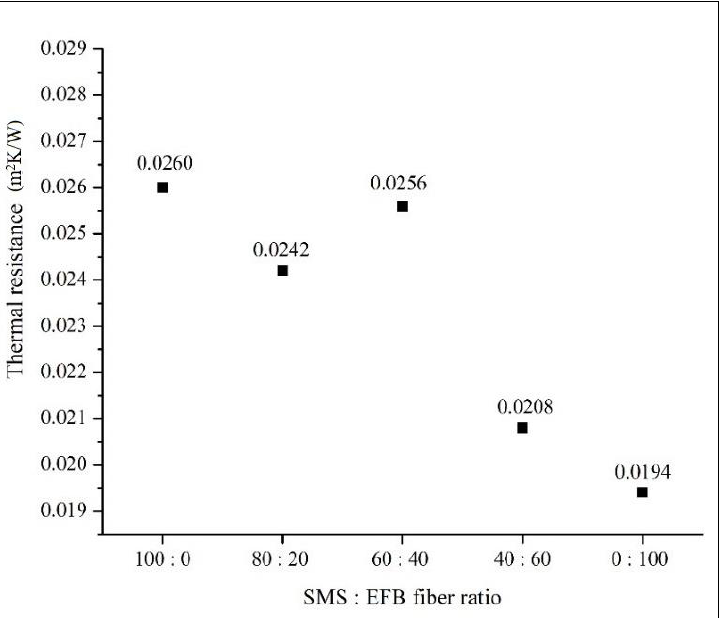
Figure 9. Effect of the fiber ratio of SMS and EFB fiber on the thermal resistance of the sandwich composite panel.